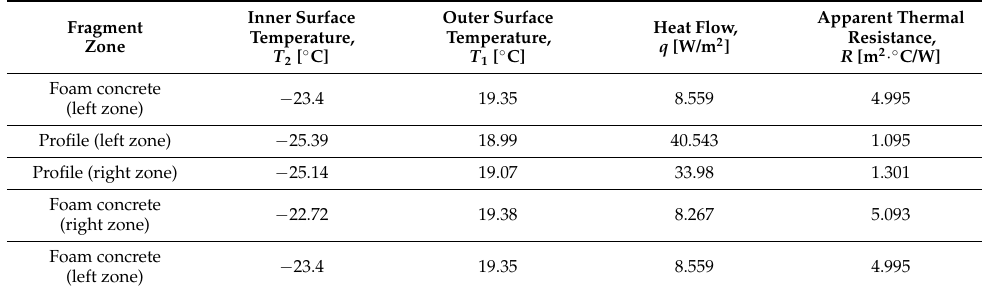
Figure 14. Heat flow dependence on time.